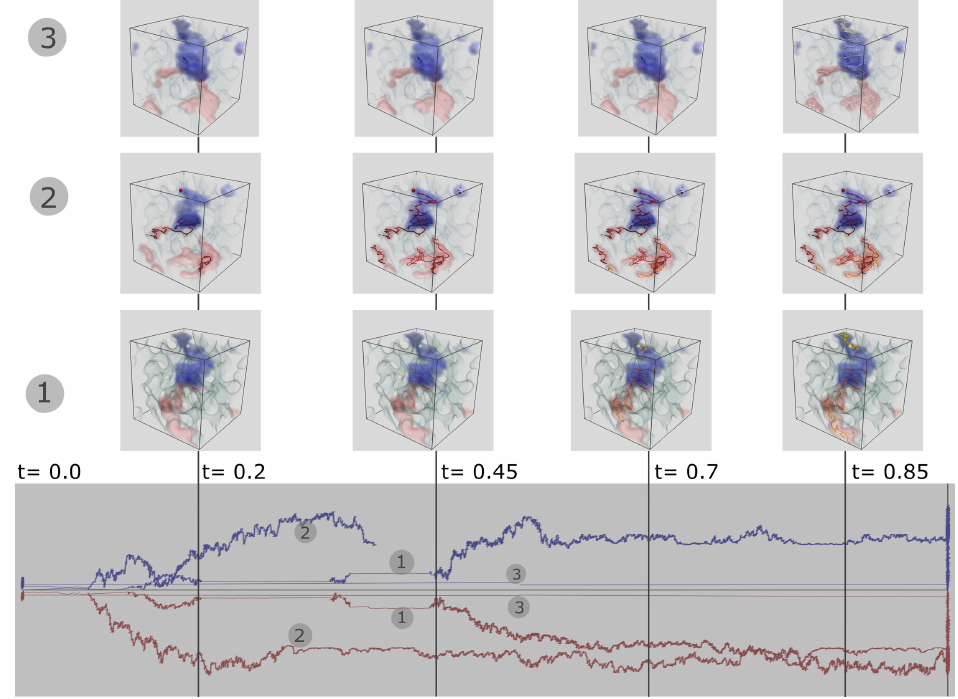
Figure 14. Three selected charge trajectories are analyzed as above using one of the summary plots. Plot uses time of charge transport along x -axis and y -axis as distance from the start point of charge transport (negative distance is used to differential acceptor and donor pairs in red and blue